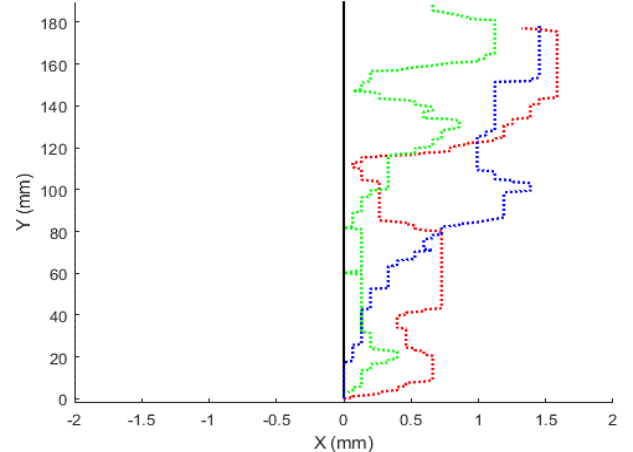
Figure 8. Robot movement along a simple trajectory (solid black line indicates the ideal trajectory; dashed red, blue, and green lines indicate trajectories followed by the robot in three different trials).